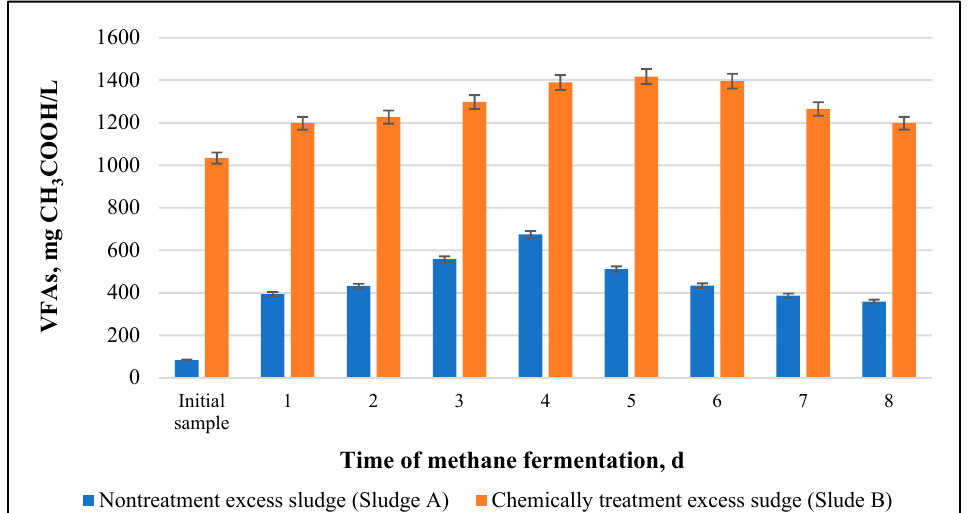
Figure 10. Generation of volatile fatty acids (VFAs) from excess sludge during methane fermenta- tion.